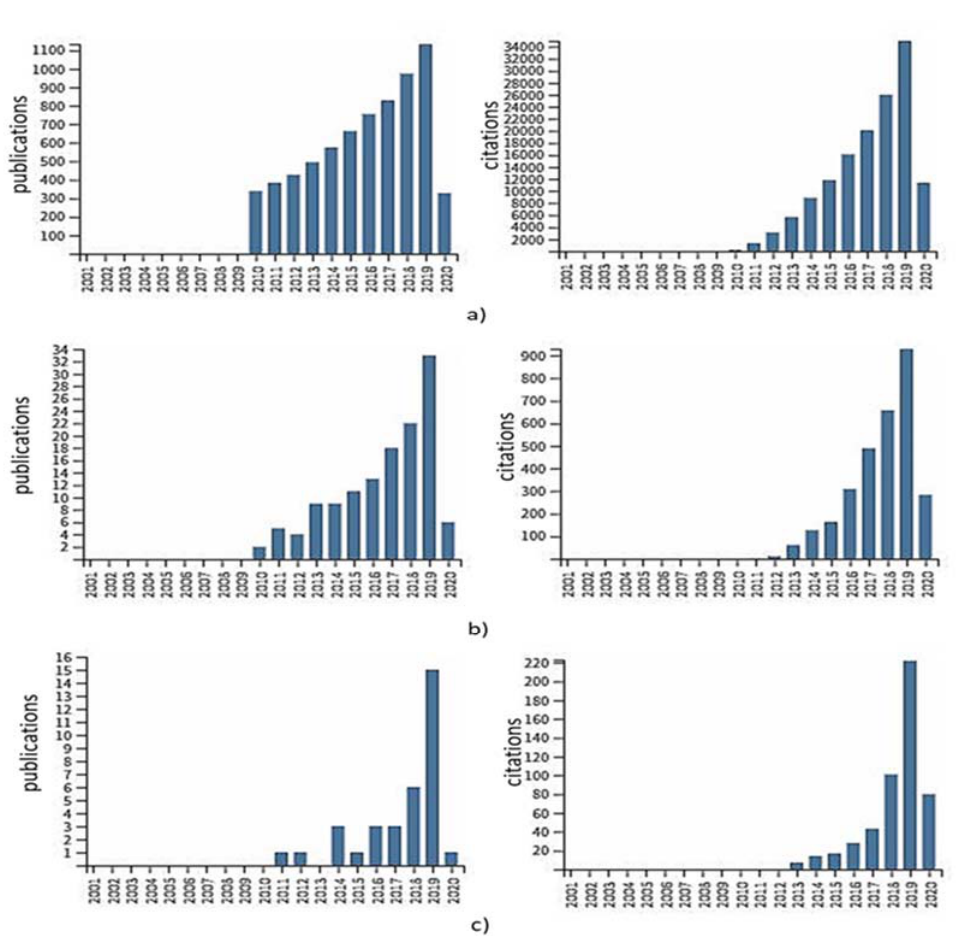
Figure 2. Trend of annual publications considering BC for 2010–2020 period. Search engine is Web of Science Core Collection and search terms ( a ), ‘bacterial cellulose’ ( b ), ‘bacterial cellulose’ AND ‘medicine’, ( c ) and ‘bacterial cellulose’ AND ‘medicine’ AND ‘review’.